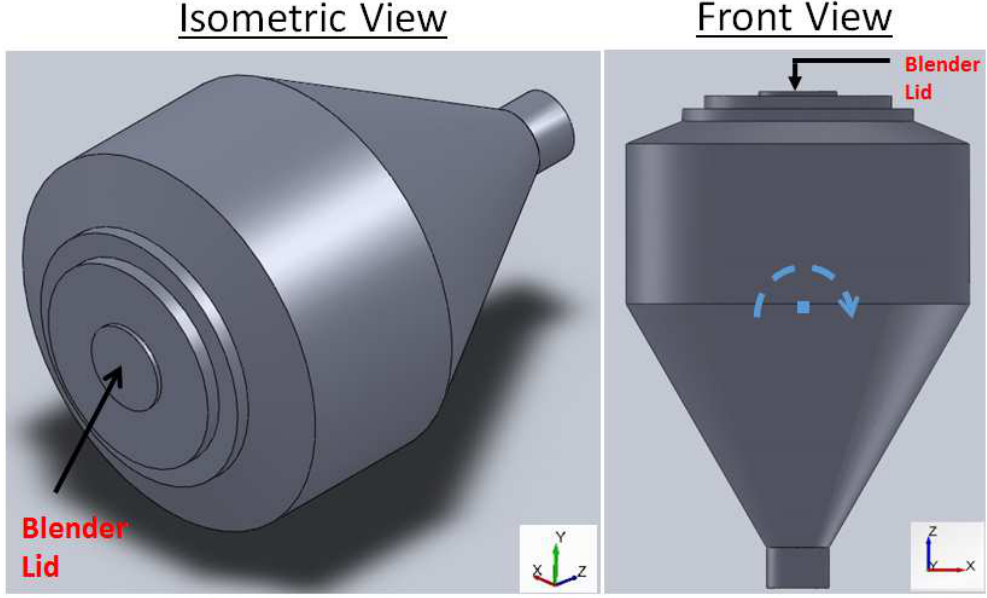
Figure 1. Pictorial representation of the bin blender showing lid location and axis of